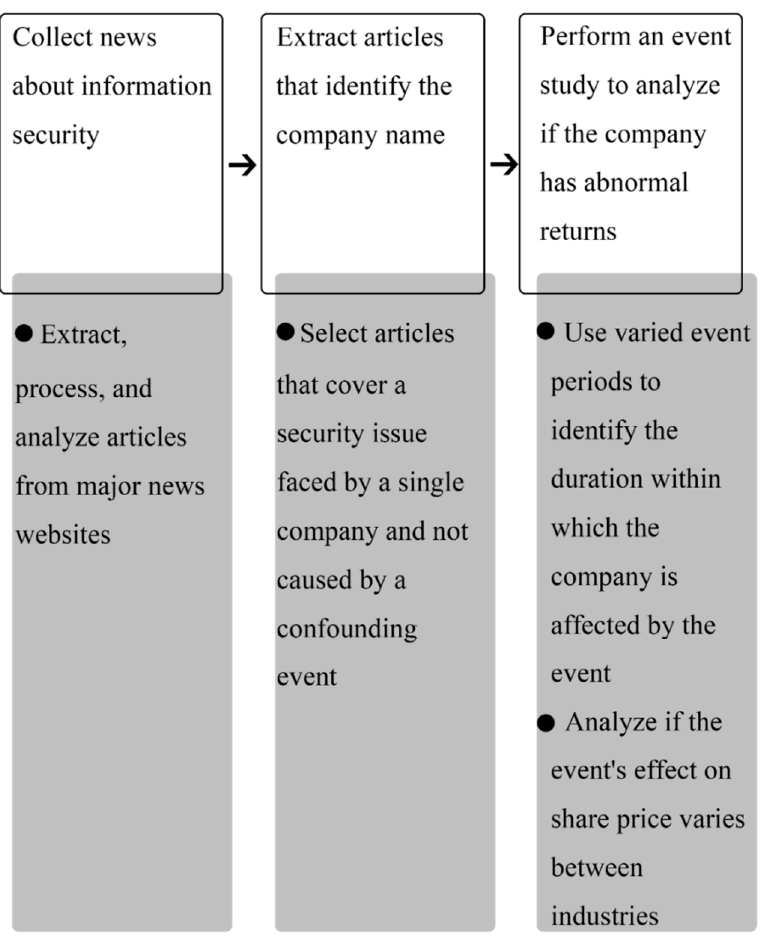
Figure 2. Steps for analyzing information security events.